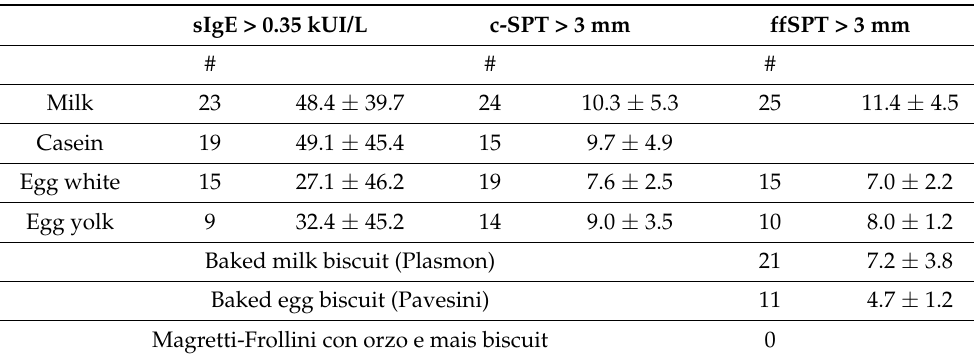
Table 2. Patients’ sensitization to milk and egg (number of patients, #; mean ± SD of sensitization values). sIgE > 0.35 kUI/L c-SPT > 3 mm ffSPT > 3